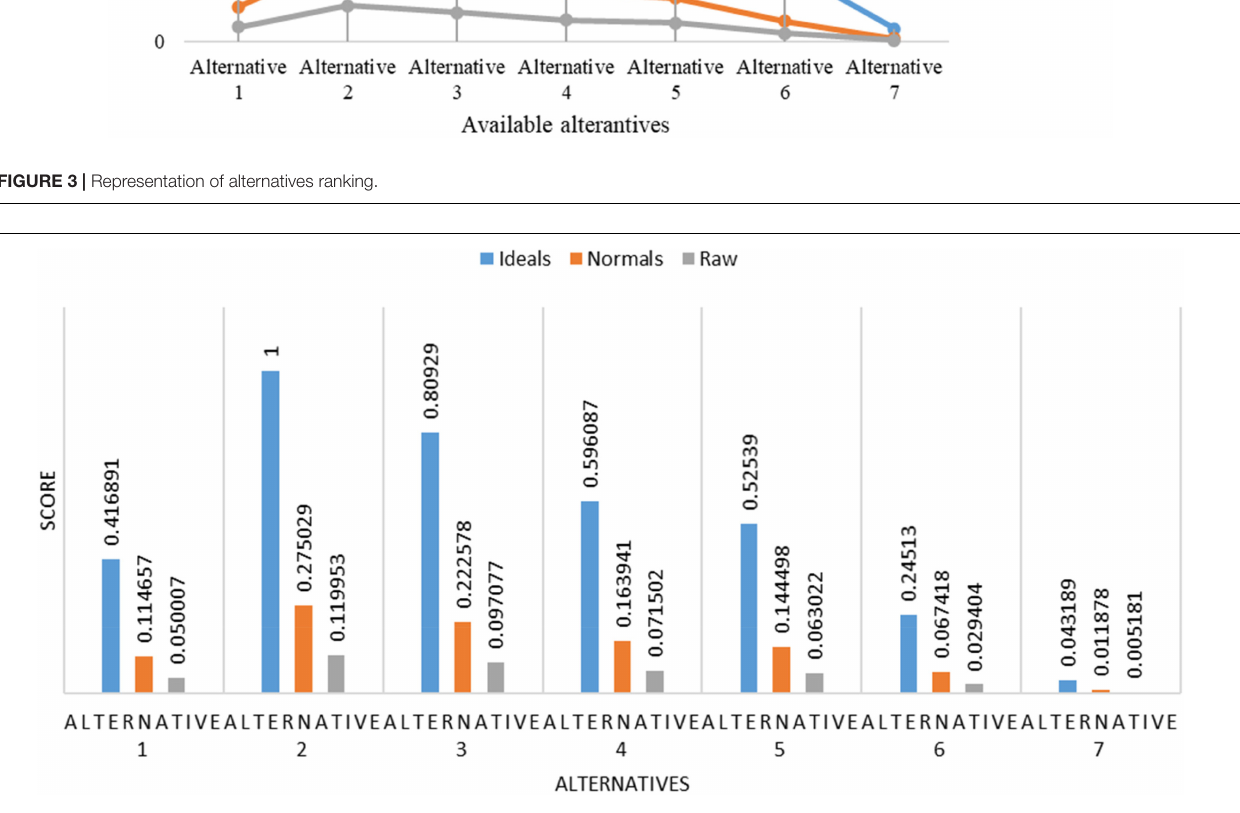
FIGURE 4 | Overall synthesis priorities for the